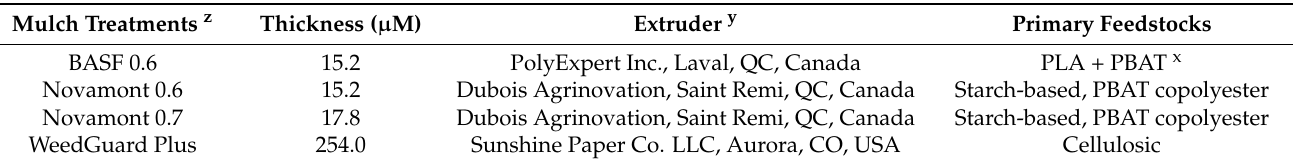
Table 1. Soil-biodegradable mulch (BDM) treatments applied in a field study in northwestern Washington, USA.